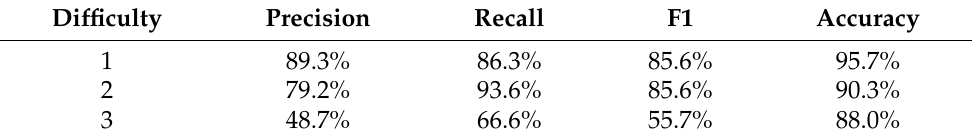
Table 6. Average results obtained for the sub-streams of the dataset, stratified by the difficulty level.